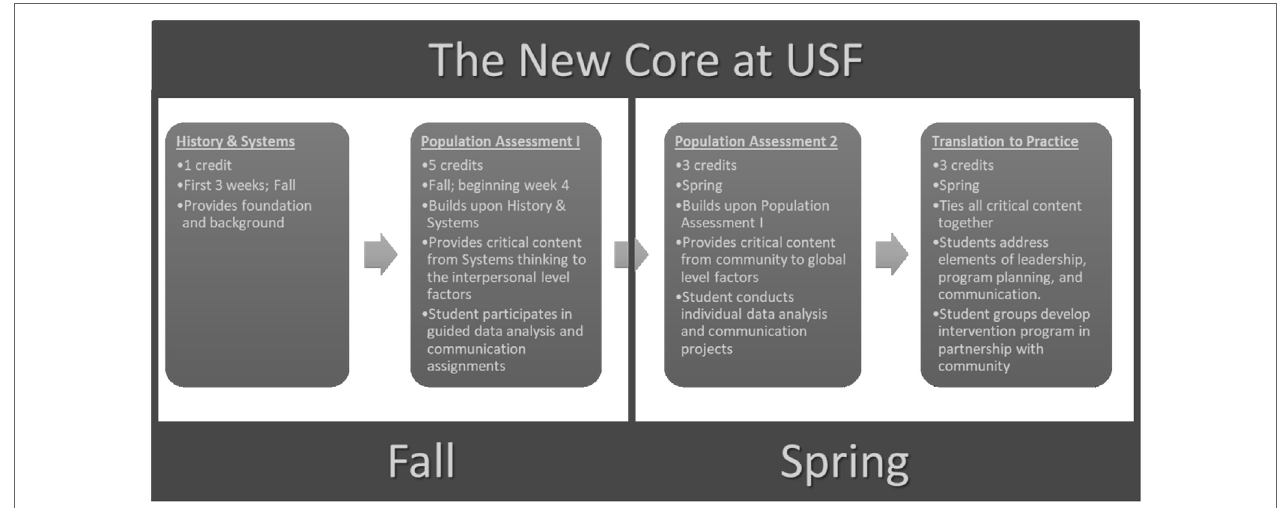
Figure 2 | Course sequencing in the transformed Masters in Public Health